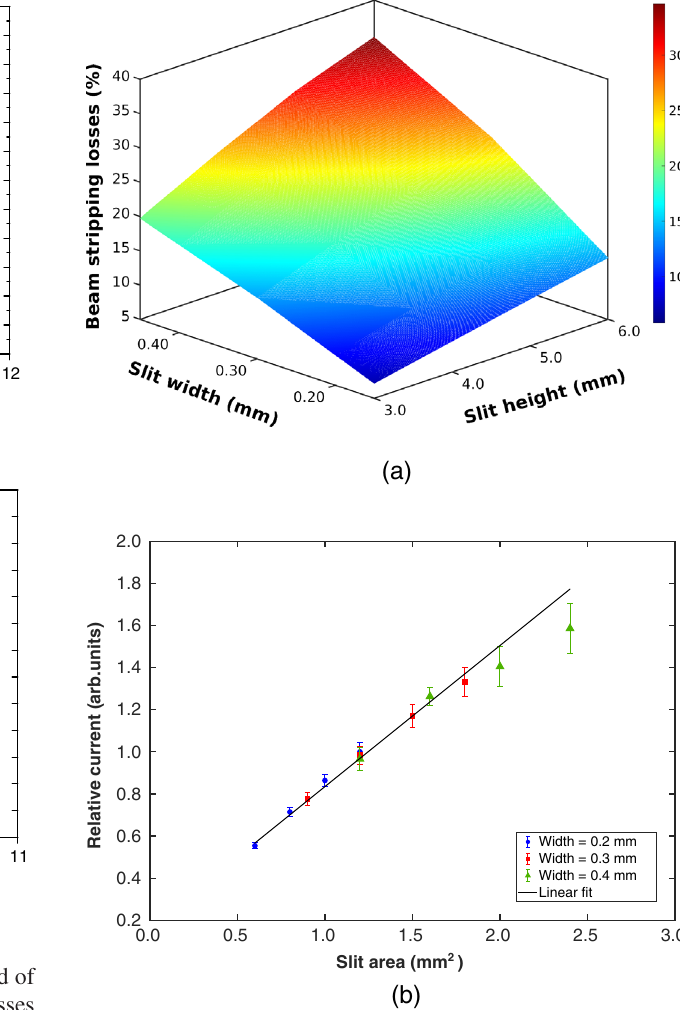
FIG. 7. (a) Beam stripping losses rate as a function of the slit height and width. The color surface mesh is interpolated from the results of the simulations. (b) Normalized relative current as a function of the slit area. The values are normalized over the expected current from the nominal slit ( 6 × 0 . 2 mm 2 ). The solid red line is a linear fit to the data weighted over the stochastic error associated with the stripping losses. The results are grouped by color and symbol according to the slit width, with each point representing a different slit